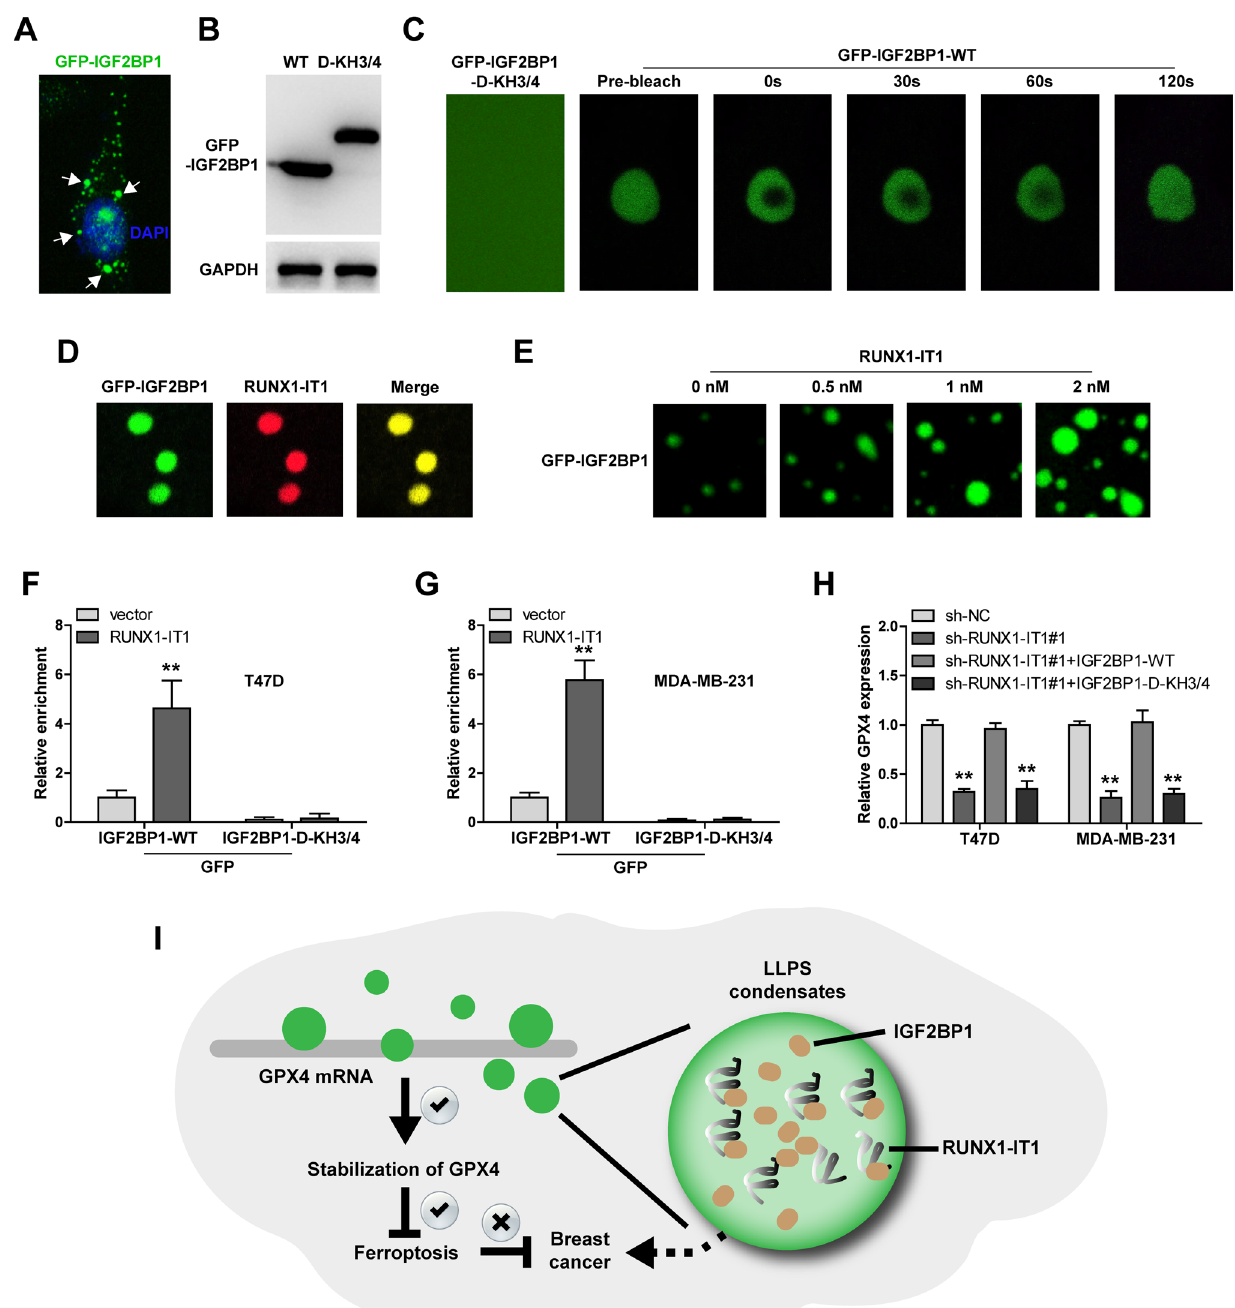
Fig. 6 RUNX1-IT1 drives IGF2BP1 protein LLPS. A Detection of green fluorescent signal in cells transfected with GFP-IGF2BP1 vector. B West- ern blot verifying protein purification of IGF2BP1 and its mutant. C FRAP assay testing the fluxility of GFP-IGF2BP1 protein. D , E In vitro phase separation assay using GFP-IGF2BP1 protein and RUNX1-IT1. F , G RIP assay testing the binding of IGF2BP1 and its mutant to GPX4 mRNA in RUNX1-IT1-overexpressed cells. H qRT-PCR analysis of GPX4 mRNA expression in RUNX1-IT1-silenced cells transfected with IGF2BP1 and its mutant vectors. I The proposed model of RUNX1-IT1 promoting breast cancer by regulating GPX4-mediated ferroptosis via driving IGF2BP1 protein